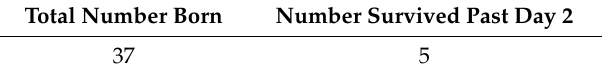
Table 2. Survival of Clptm1l del/del